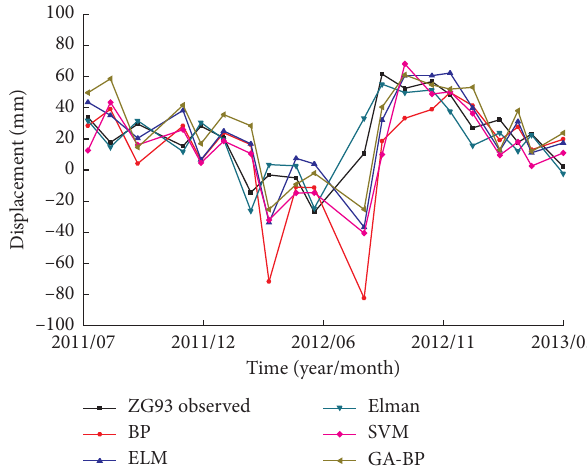
Figure 12: Prediction performance through other models on point ZG93 in the Baishuihe landslide